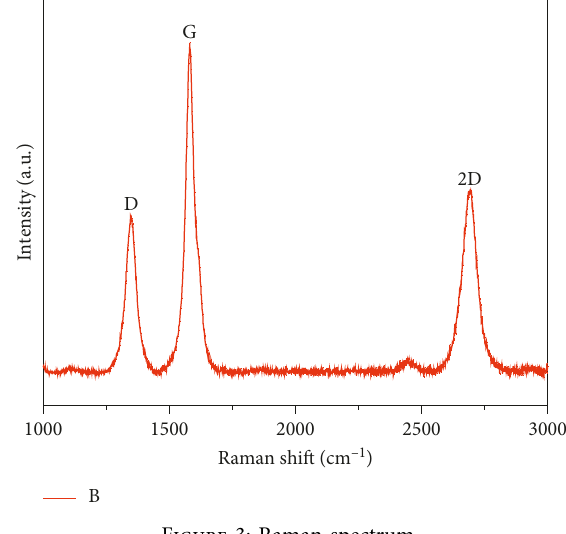
Figure 3: Raman spectrum.